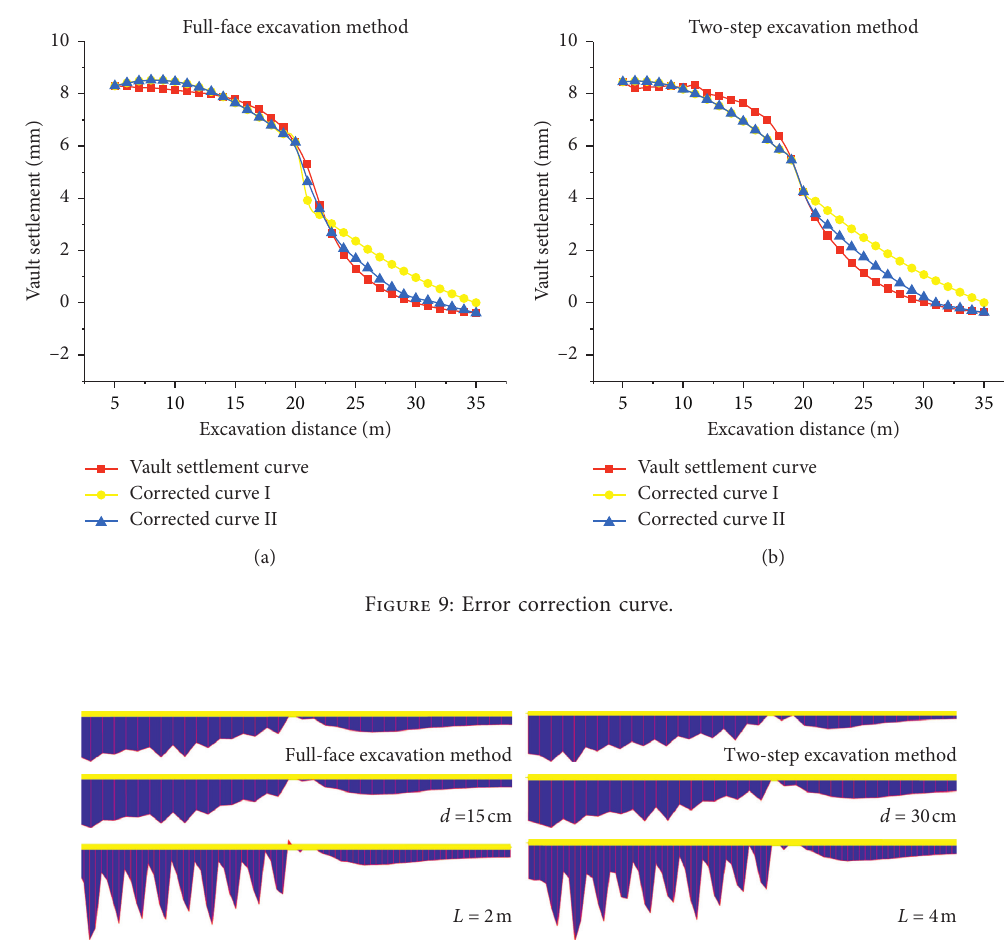
Figure 10: Geogrid axial force diagram.